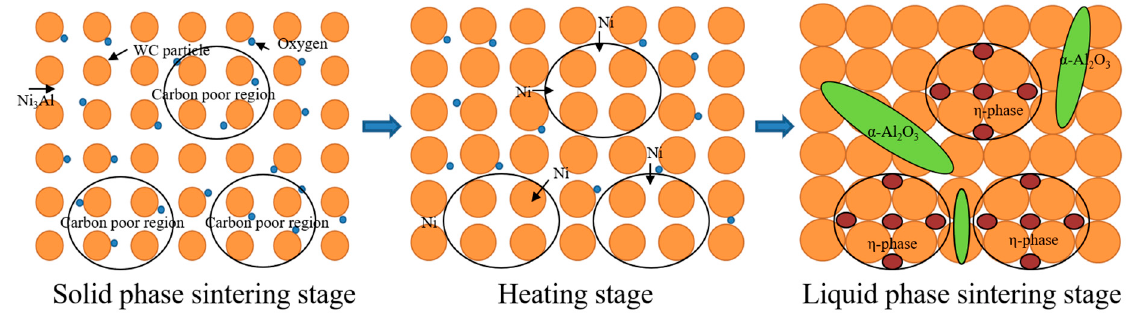
Figure 8. Schematic diagram for the generation of η -phase and α -Al 2 O 3 in WC-Ni 3 Al composites milled by CH 3 CH 2 OH.